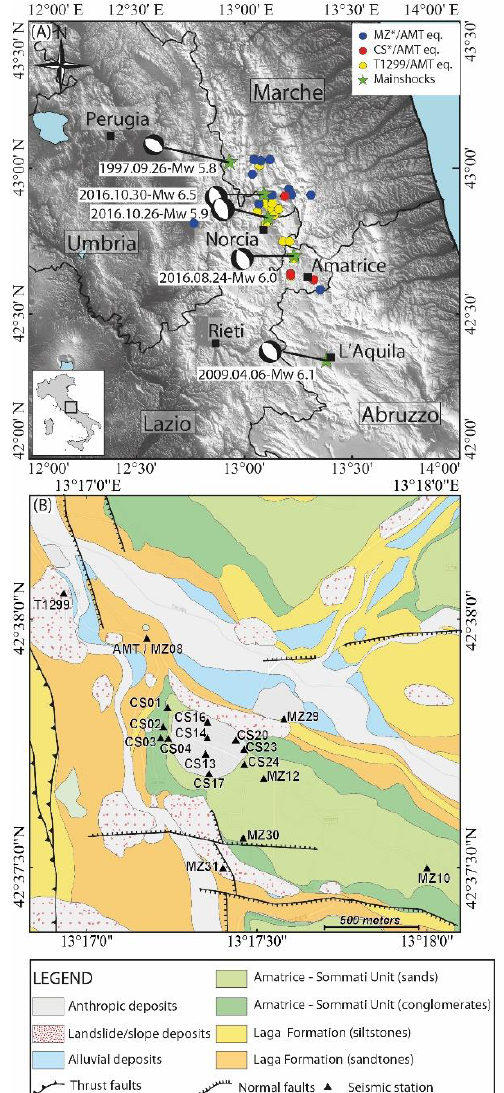
Figure 1. ( A ) Map of the study area with the strongest earthquakes that affected central Italy from 1997 to 2016 and the associated TDMT focal mechanisms (http://cnt.rm.ingv.it/tdmt, accessed on 24 April 2021; [35]); blue, red, and yellow dots represent the location of the seismic events used in this study. ( B ) Schematic geological map of the Amatrice downtown (modified after [27]) generated by GIS (base map source: Esri, user community, geographic information system. Coordinate system and projection: World Geodetic System 1984–Web Mercator Auxiliary Sphere); black triangle represents the position of seismic stations whose recordings are used for the